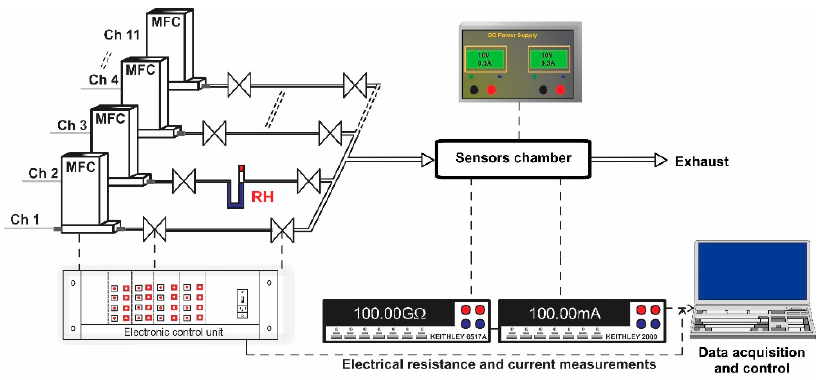
Figure 5. Experimental setup used for gas sensing performance evaluation. Real time acquiring electrical resistance and current data.